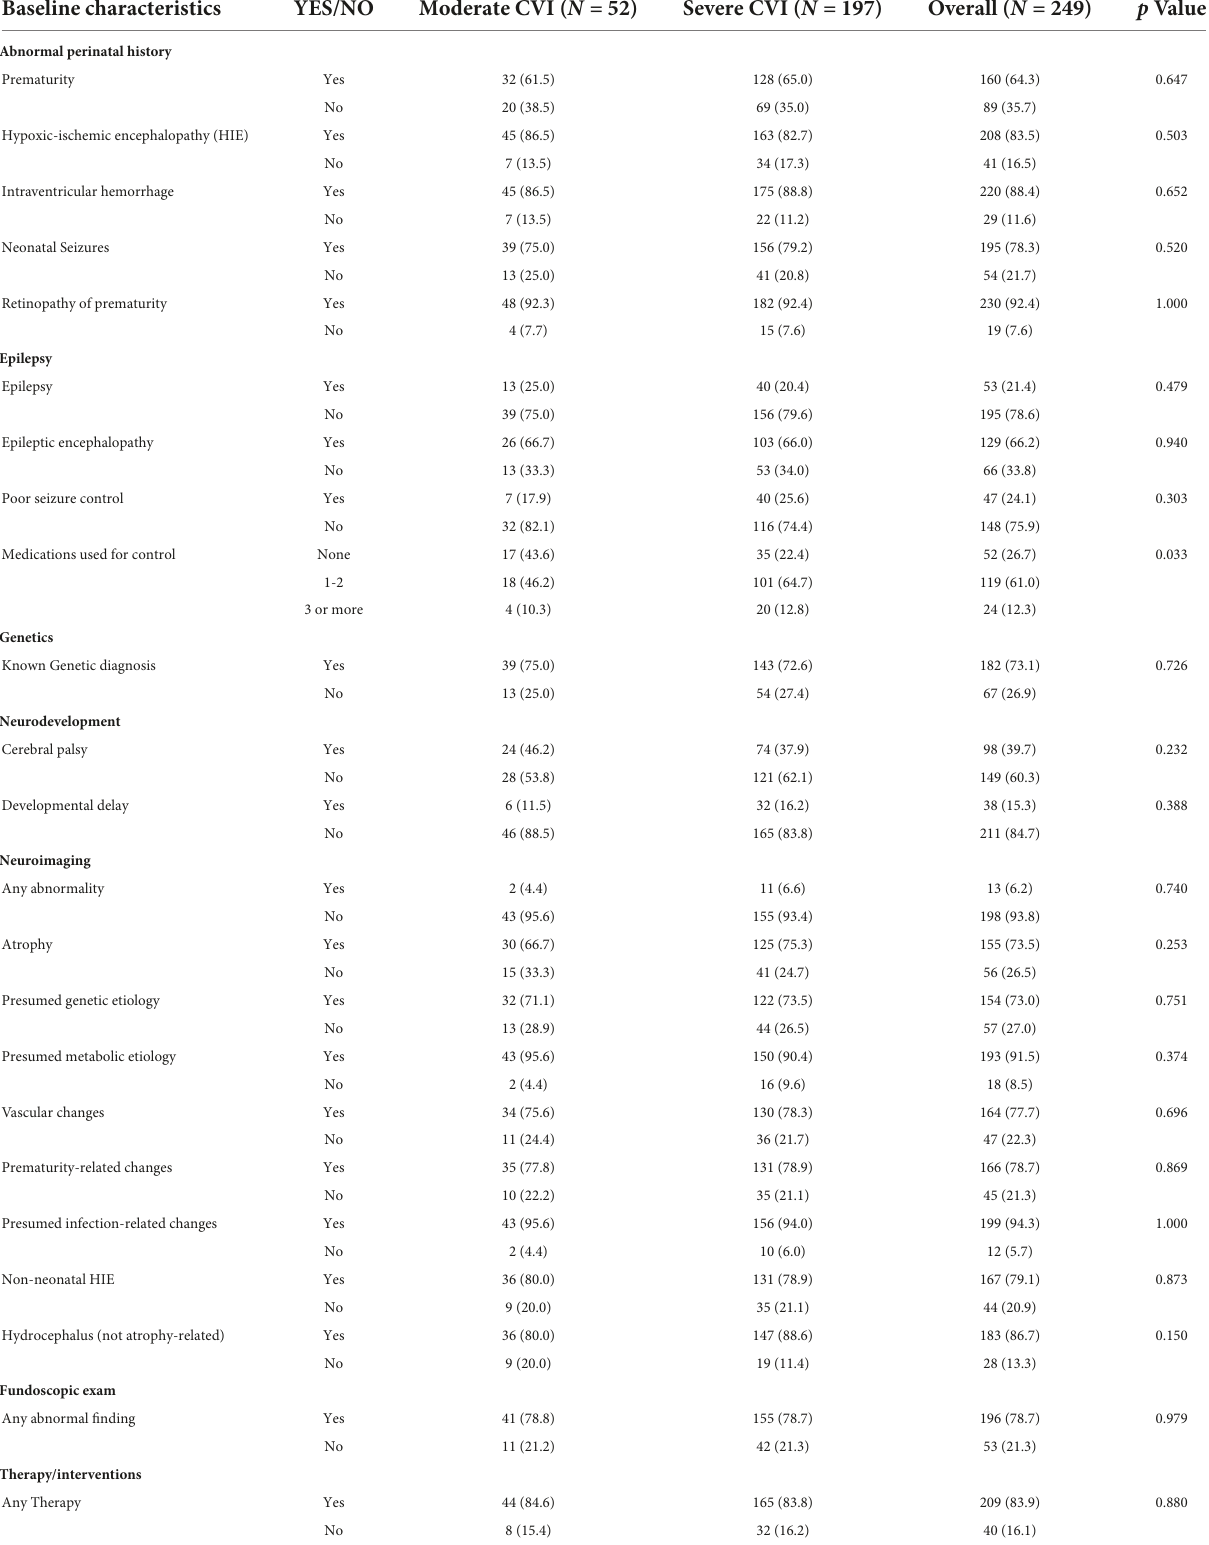
TABLE 2 Associations between each predictor and the CVI group at diagnosis. Baseline